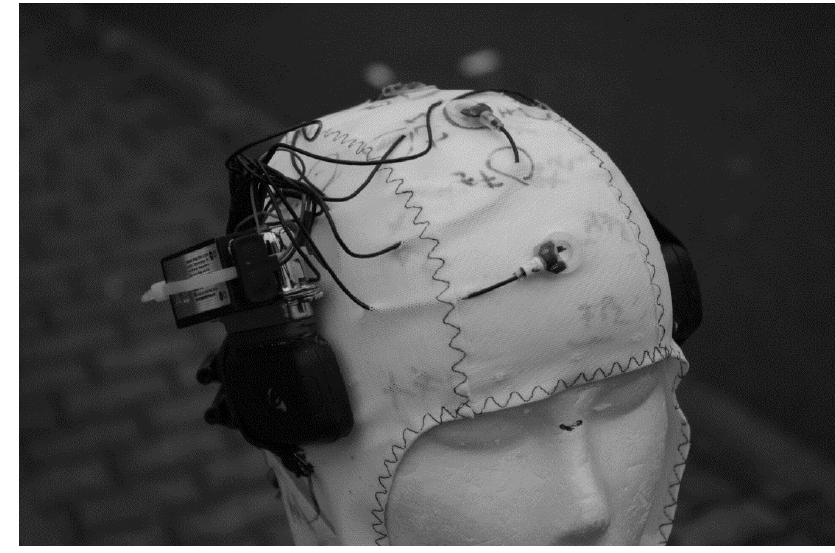
Figure 8. The modified Emotiv headset combined with the EasyCap active electrodes.